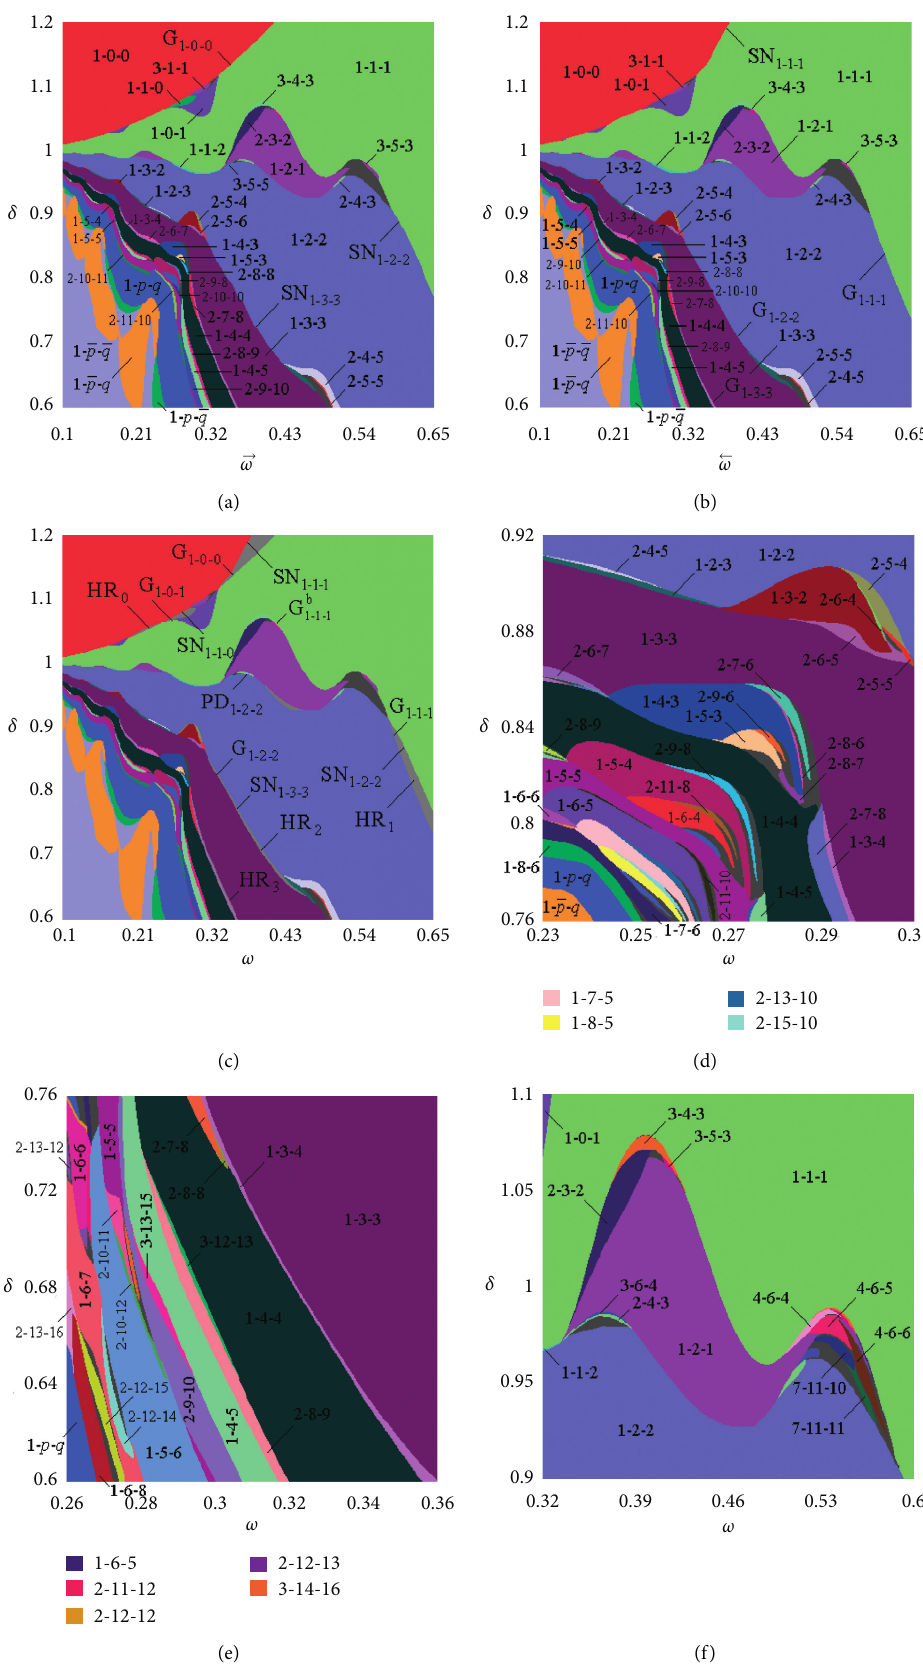
Figure 3: Local detailed description of Figure 2(a) mutual transition characteristics between adjacent basic periodic vibrations1 − p − p and1 − ( p + 1 ) − ( p + 1 )